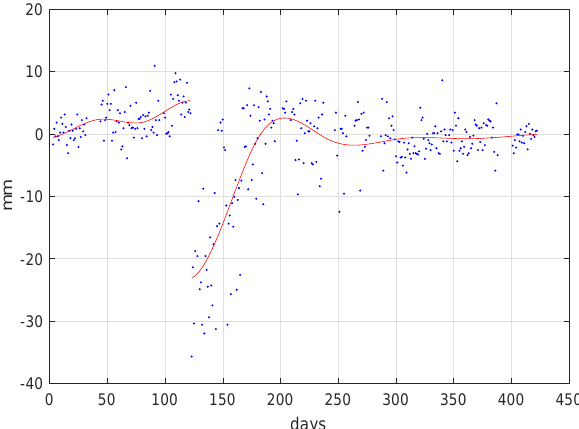
Figure 11. East point time series, East component. Observed values (blue dots) and model (red line)